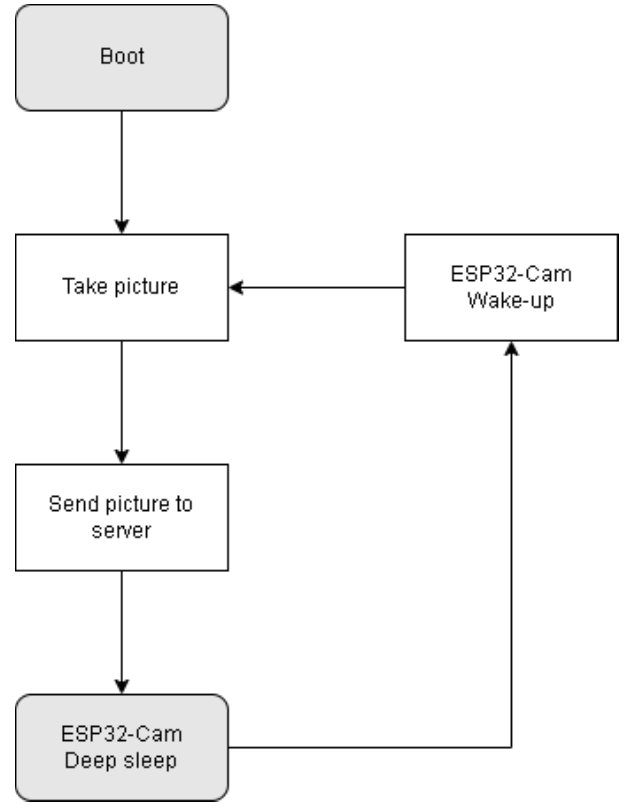
Figure 9. Simplified ESP32-Cam program